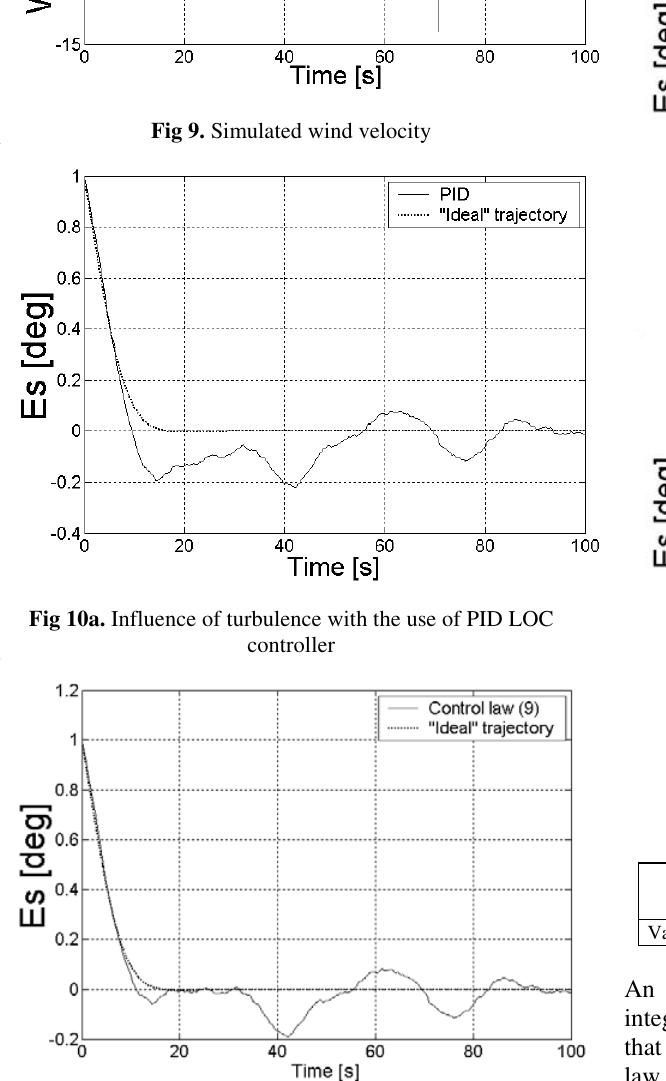
Fig 9. Simulated wind velocity